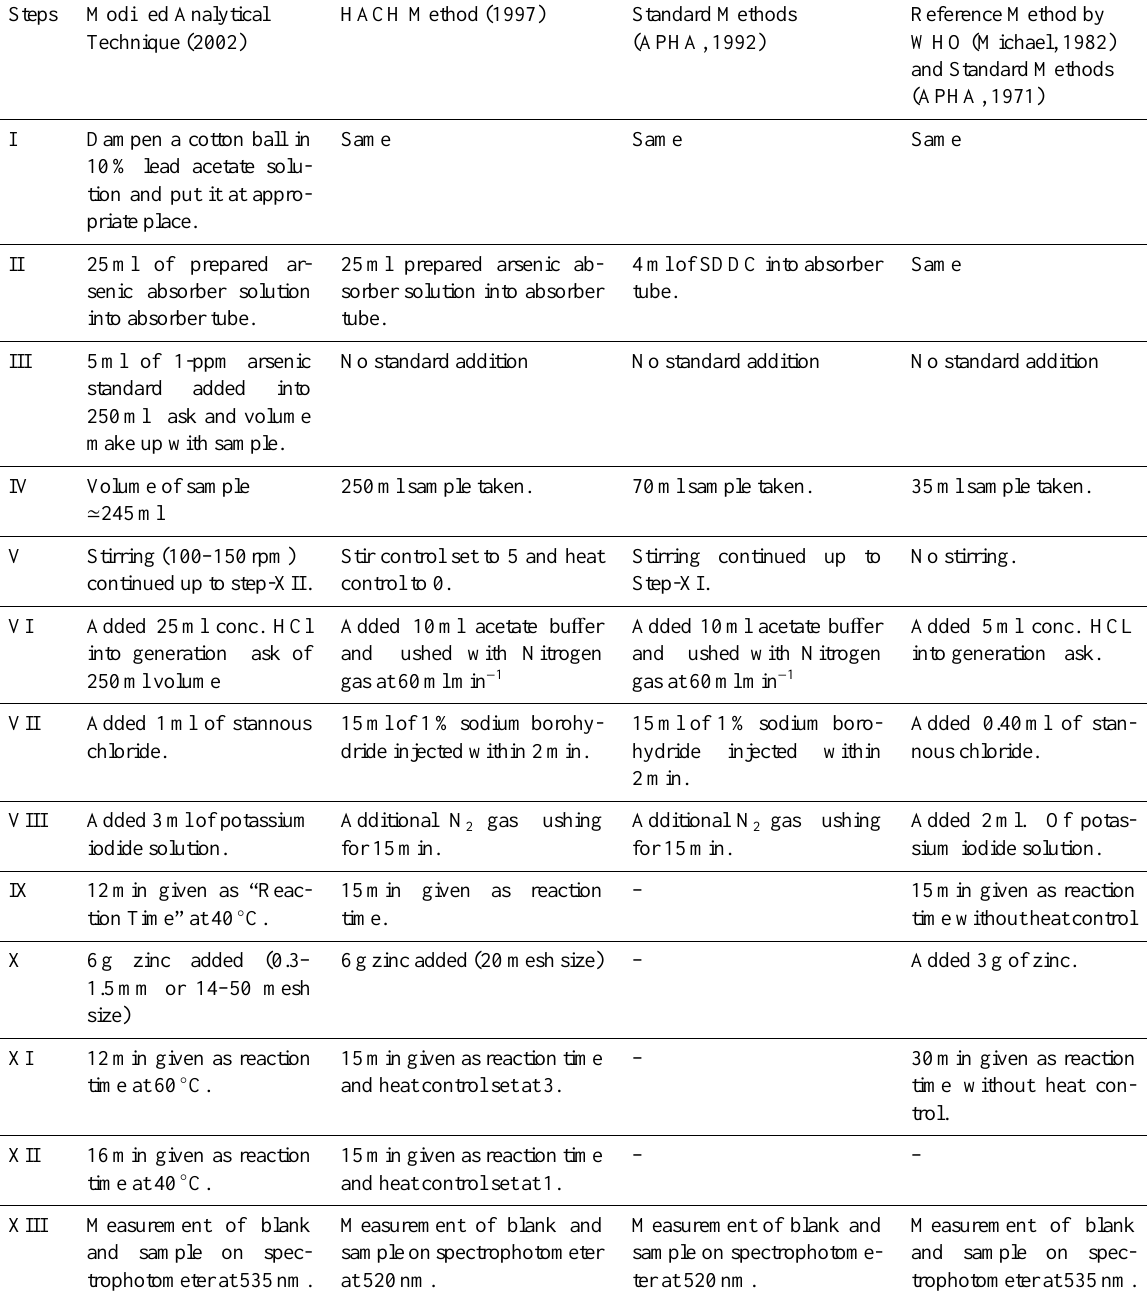
Table 4. Comparison of modified technique with other spectrometric